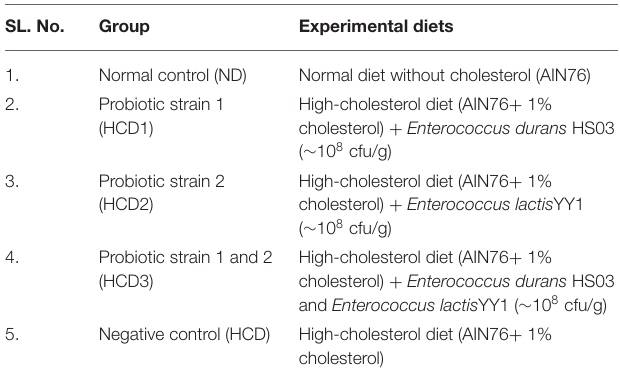
TABLE 2 | Experimental grouping used in this study. SL.